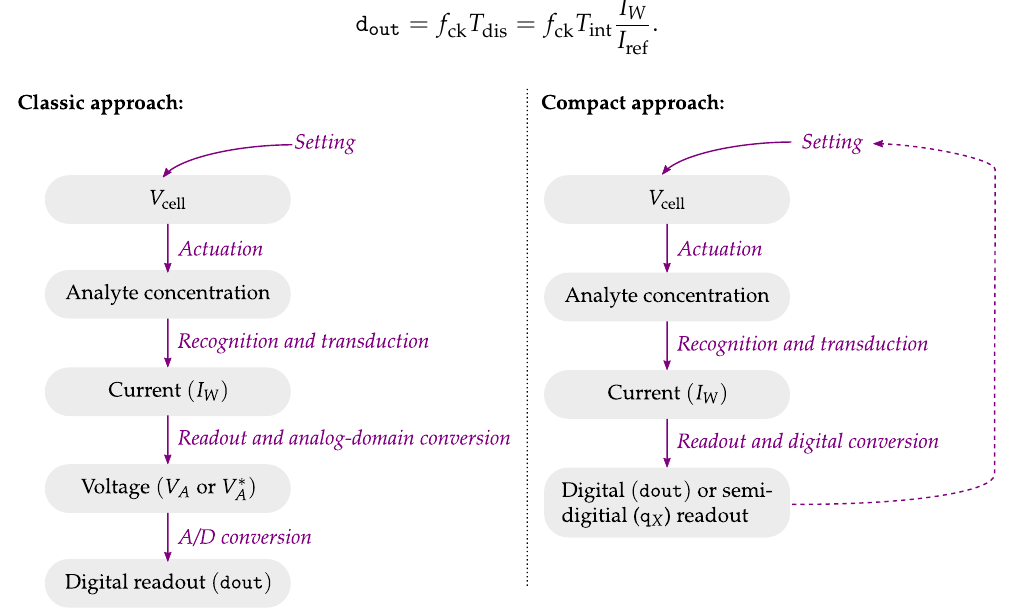
Figure 14. Classic and compact potentiostat approaches.